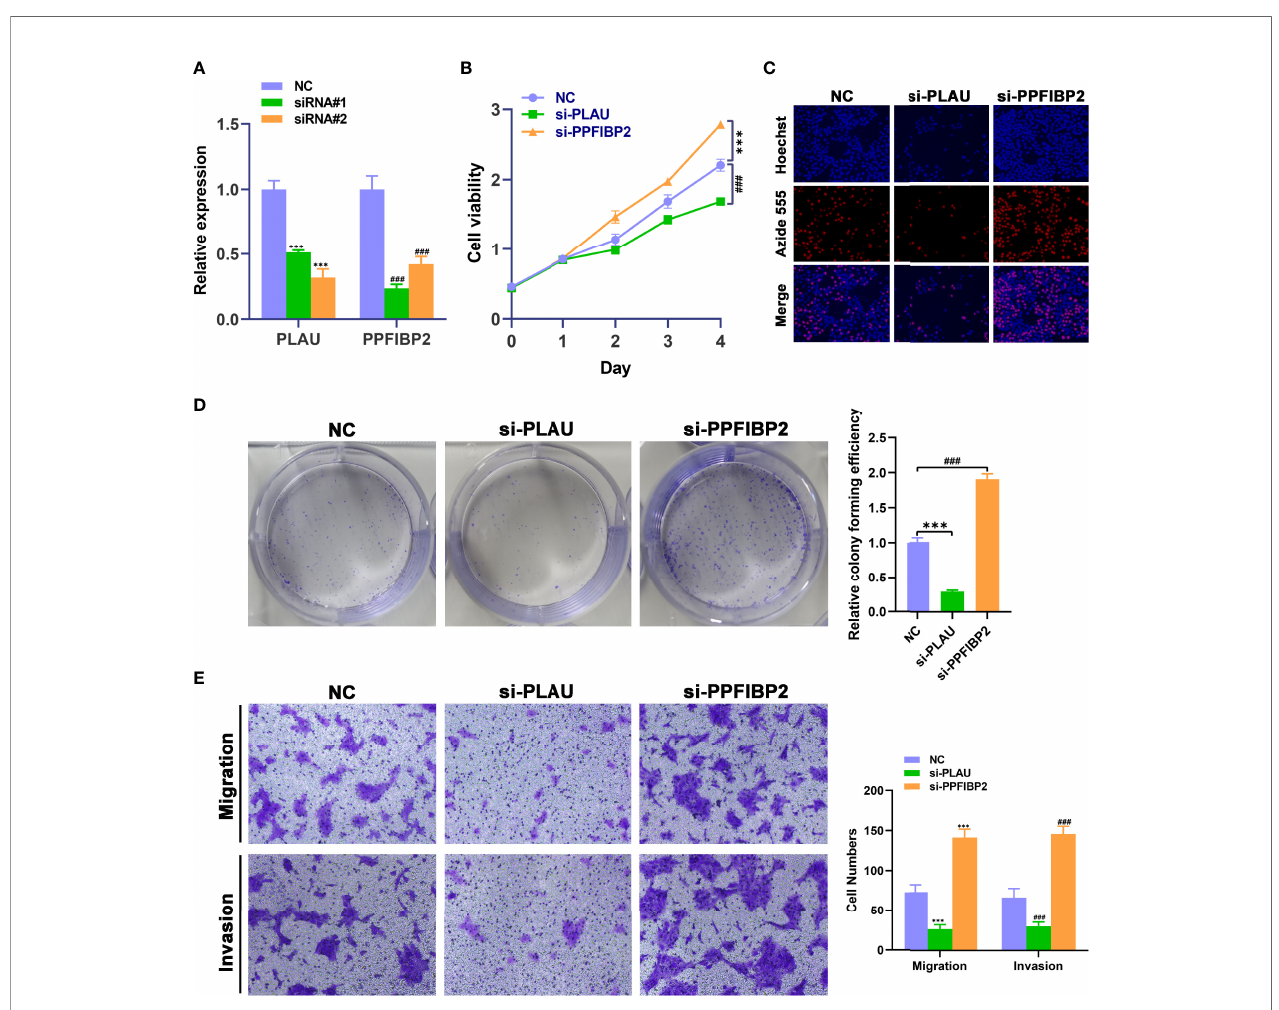
FIGURE 8 | Biological functional validation of PLAU and PPFIBP2 in TSCC cells. (A) Silencing ef fi ciency of PLAU and PPFIBP2 detected using qRT-PCR. CCK8 assay (B) , EDU assay (C) , and colony formation assay (D) showing the in fl uence of PLAU and PPFIBP2 depletion on proliferation of Cal-27 cells. (E) Transwell assay was used to examine the effects of PLAU and PPFIBP2 silence on migration and invasion ability of Cal-27 cells (* p < 0.05, ** p < 0.01, and *** p < 0.001, n =